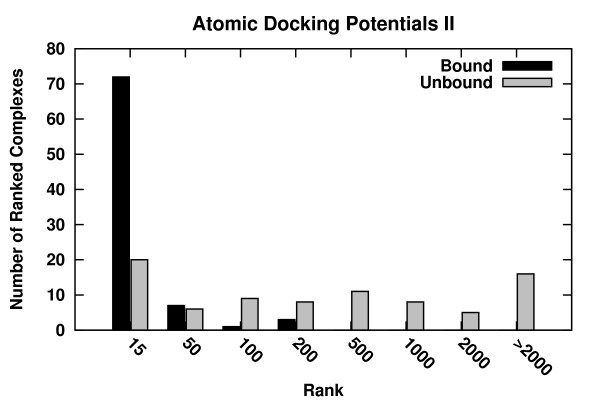
Ranking success histogram of the ADPs-II using dataset 1 [35]. For each complex decoys were ranked order according to the binding energy alone and the rank of the best (lowest energy) near-native (RMSD ≤5Å) decoy was counted. The histogram shows the number of complexes, whose hits were ranked at the top 15, 16-50, 51-100, 101-200, 201-500, 501-1000, 1001-2000, and > 2000 places in the bound (black) and unbound (gray) cases.